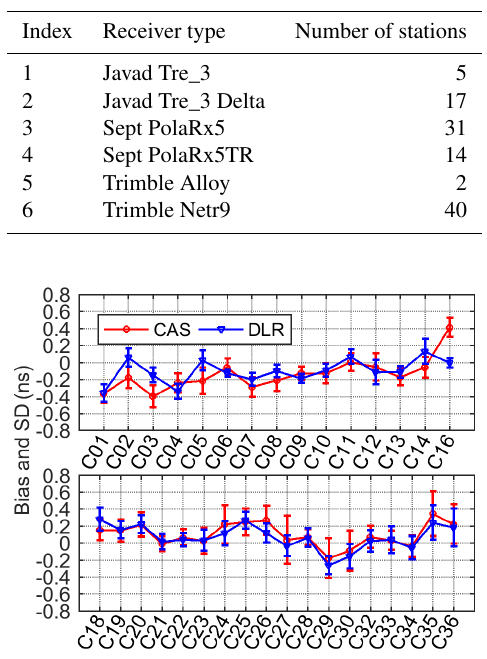
Figure 3. The mean difference and rms of estimated satellite DCB with respect to CAS and